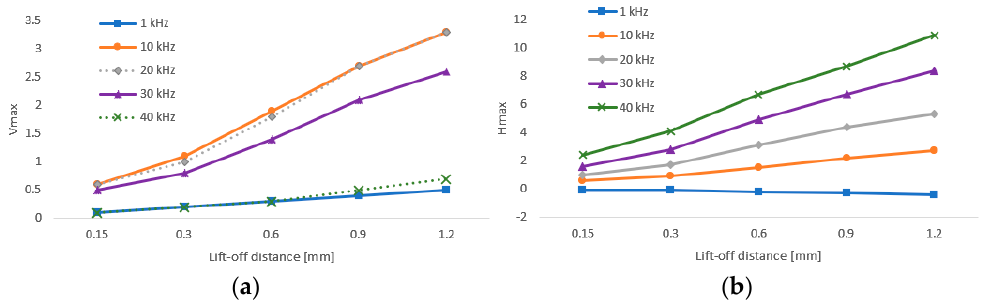
Figure 6. Vmax ( a ) and Hmax ( b ) signal-to-lift-off variation (P2 probe).